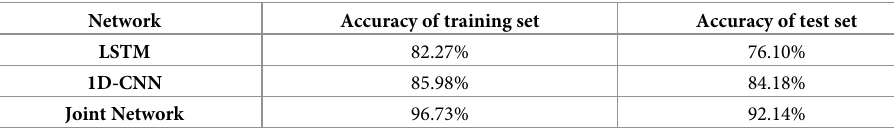
Table 5. Comparison of three kinds of network recognition